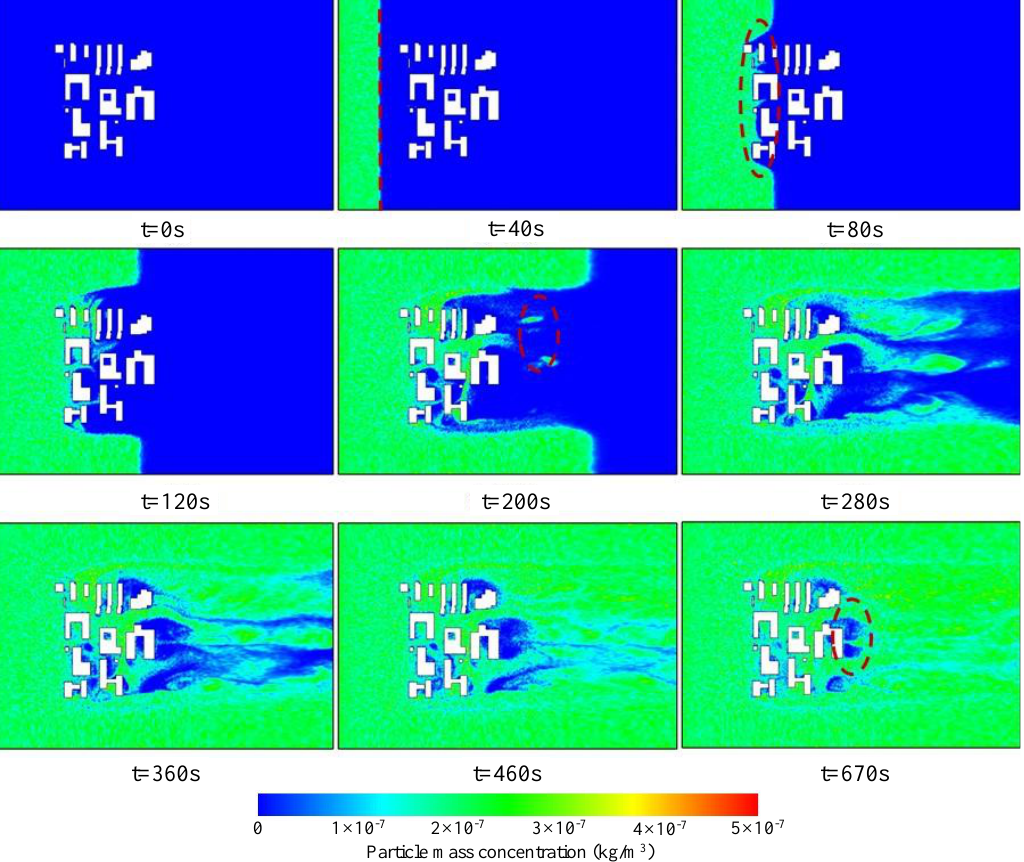
Figure 10. Contours of particle mass concentration on the horizontal plane of z = 2 m at the dispersion phases from t = 0 s to t = 670